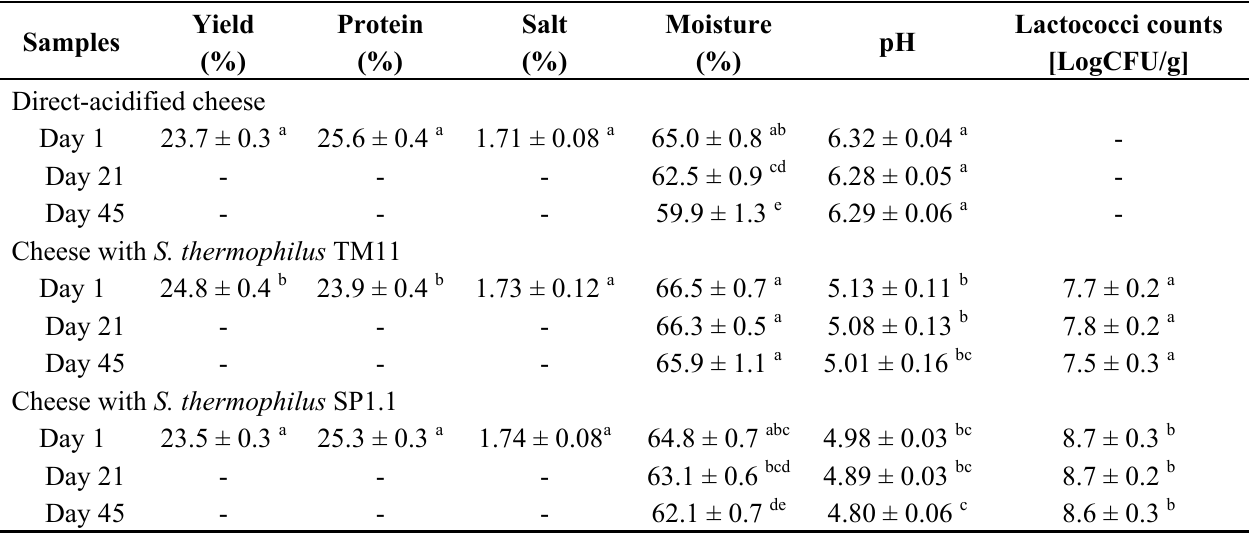
Table 1. Yield, protein, salt, moisture, pH and lactococci counts of